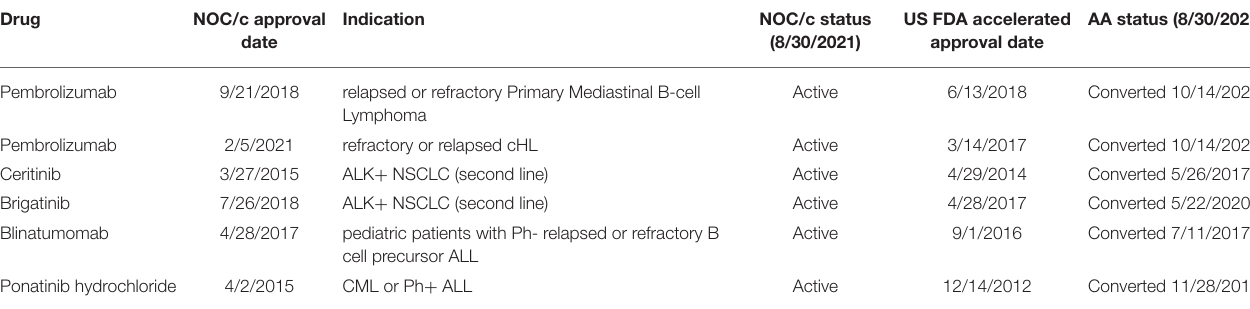
TABLE 2 | NOC/c and AA Approvals, converted to regular approval in US and not in